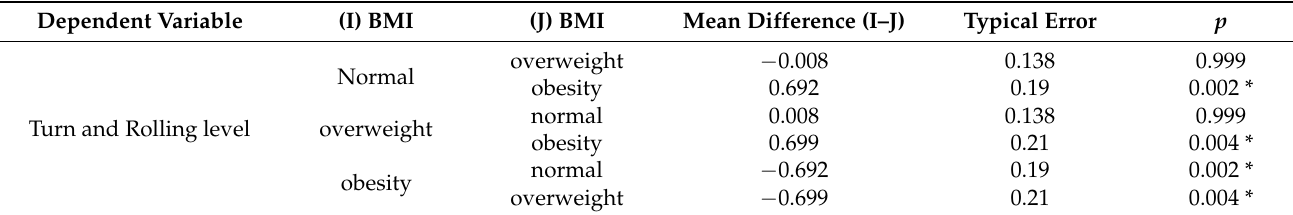
Table 7. Significance of difference in the level of rolling skill between groups of BMI. Dependent